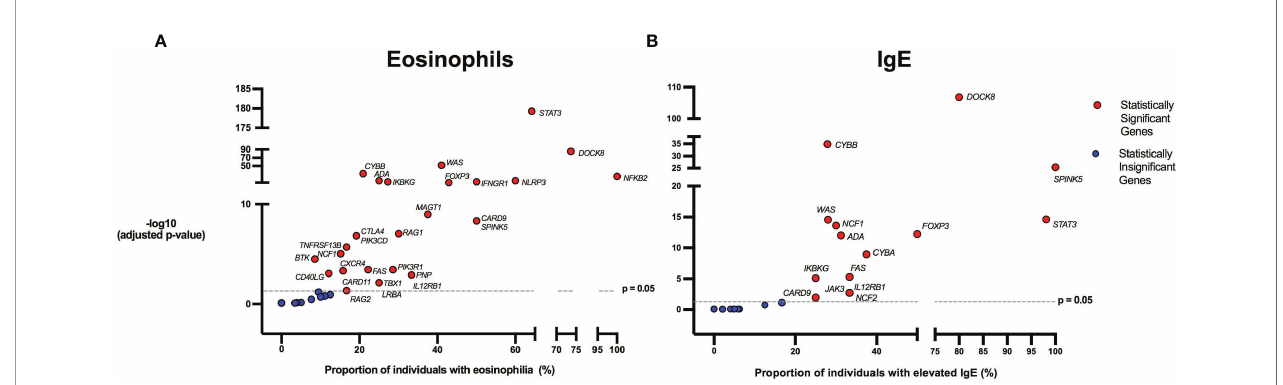
FIGURE 3 | Inborn errors of immunity associated with eosinophilia and elevated IgE. Volcano plots show the proportion of eosinophilia and elevated IgE on the x- axis. The y-axis shows the -log10 of the adjusted p-value based on the two-proportion z-test, performed by comparing the proportion of eosinophilia/elevated IgE for each gene to the proportion of values in the reference population falling above the upper limit of normal (2.5%). Dotted line indicates the signi fi cance threshold of the adjusted p-value at 0.05 and genes above the line are statistically signi fi cant. HGNC gene symbols used. (A) IEIs caused by monogenic defects in 29 genes (red) were found to be signi fi cantly associated with eosinophilia compared to the reference population age strati fi ed upper limit. (B) IEIs caused by monogenic defects in 15 genes (red) were found to be signi fi cantly associated with elevated IgE compared to the age strati fi ed upper limit.